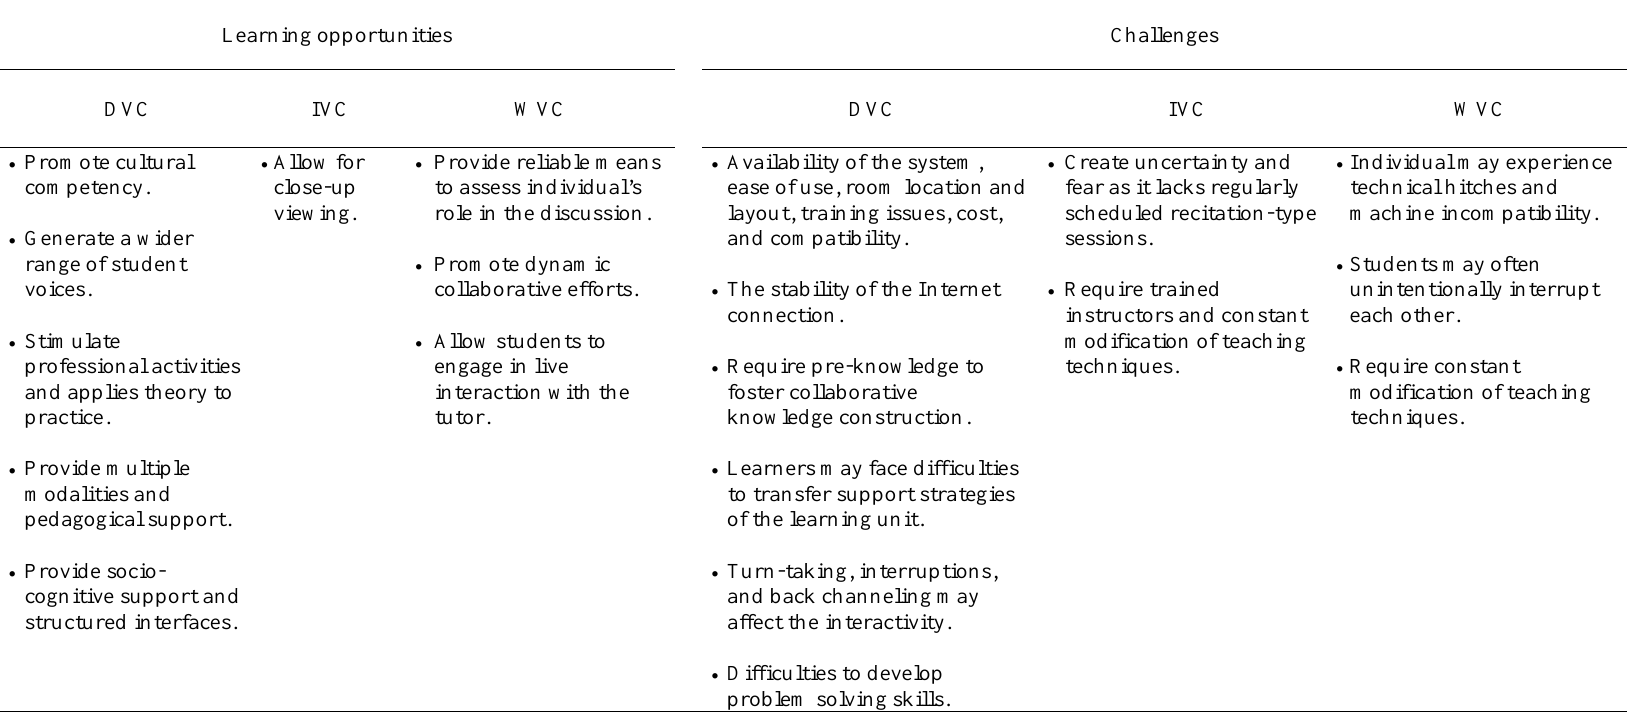
Major Learning Opportunities and Challenges of DVC, IVC, and WVC Reported in the Studies Learning